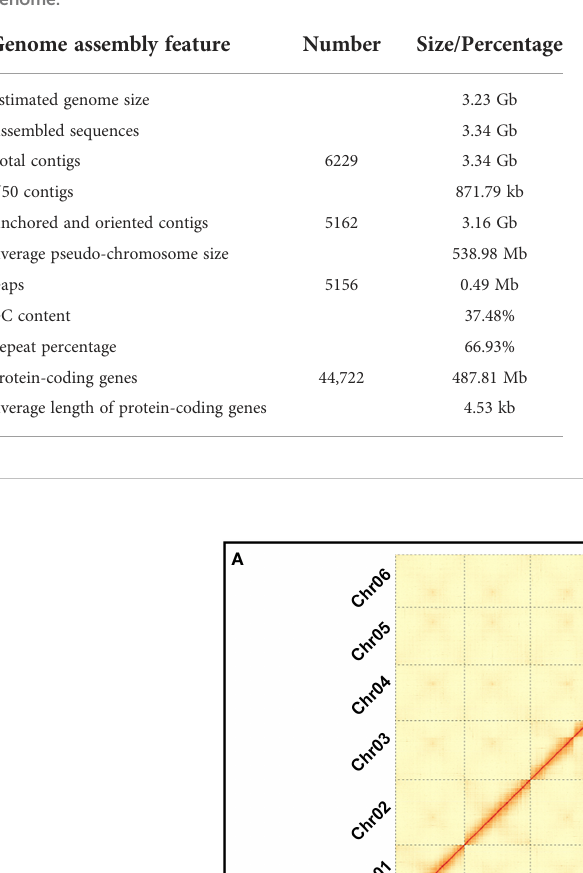
TABLE 1 Assembly and annotation statistics of E. pubescens genome.